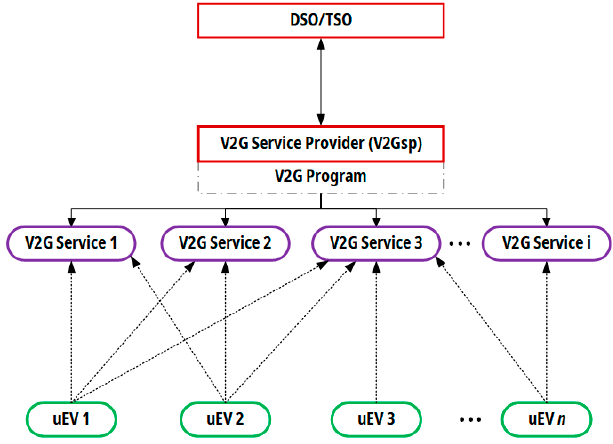
Figure 2. Block diagram of V2G Program.